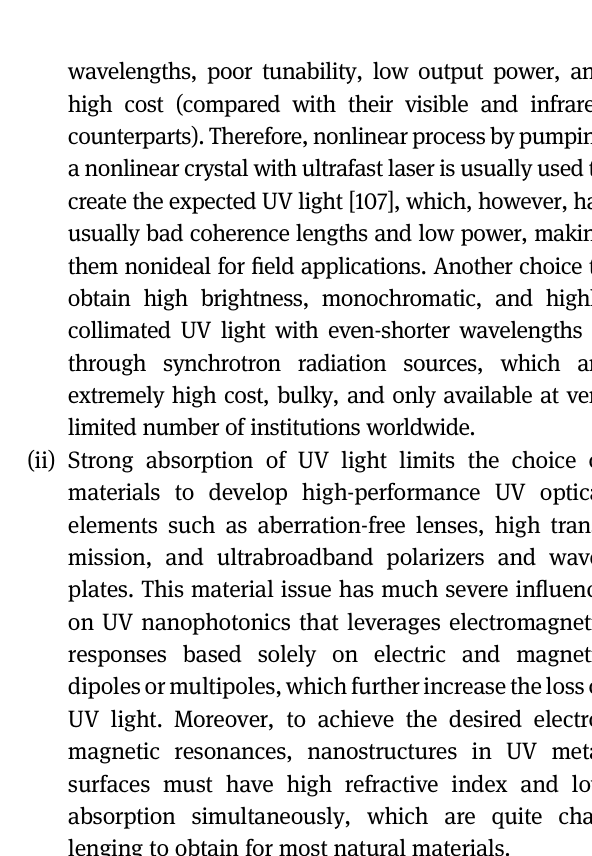
Figure 11: Photoemission spectroscopy with a submicrometer spot created by focusing the vacuum UV laser with a zone-plate flat lens. (a) Sketch of the spectroscopy. (b) Microscopy image of fabricated lens. (c) The experimental measured focal spot around the focal plane. (d – e) The microscopy (d) and scanned (e) images of the graphene flakes. The transmission of the scanned image can be used to calculate the layer number of the graphene flakes. Mao et al. [108]. Author